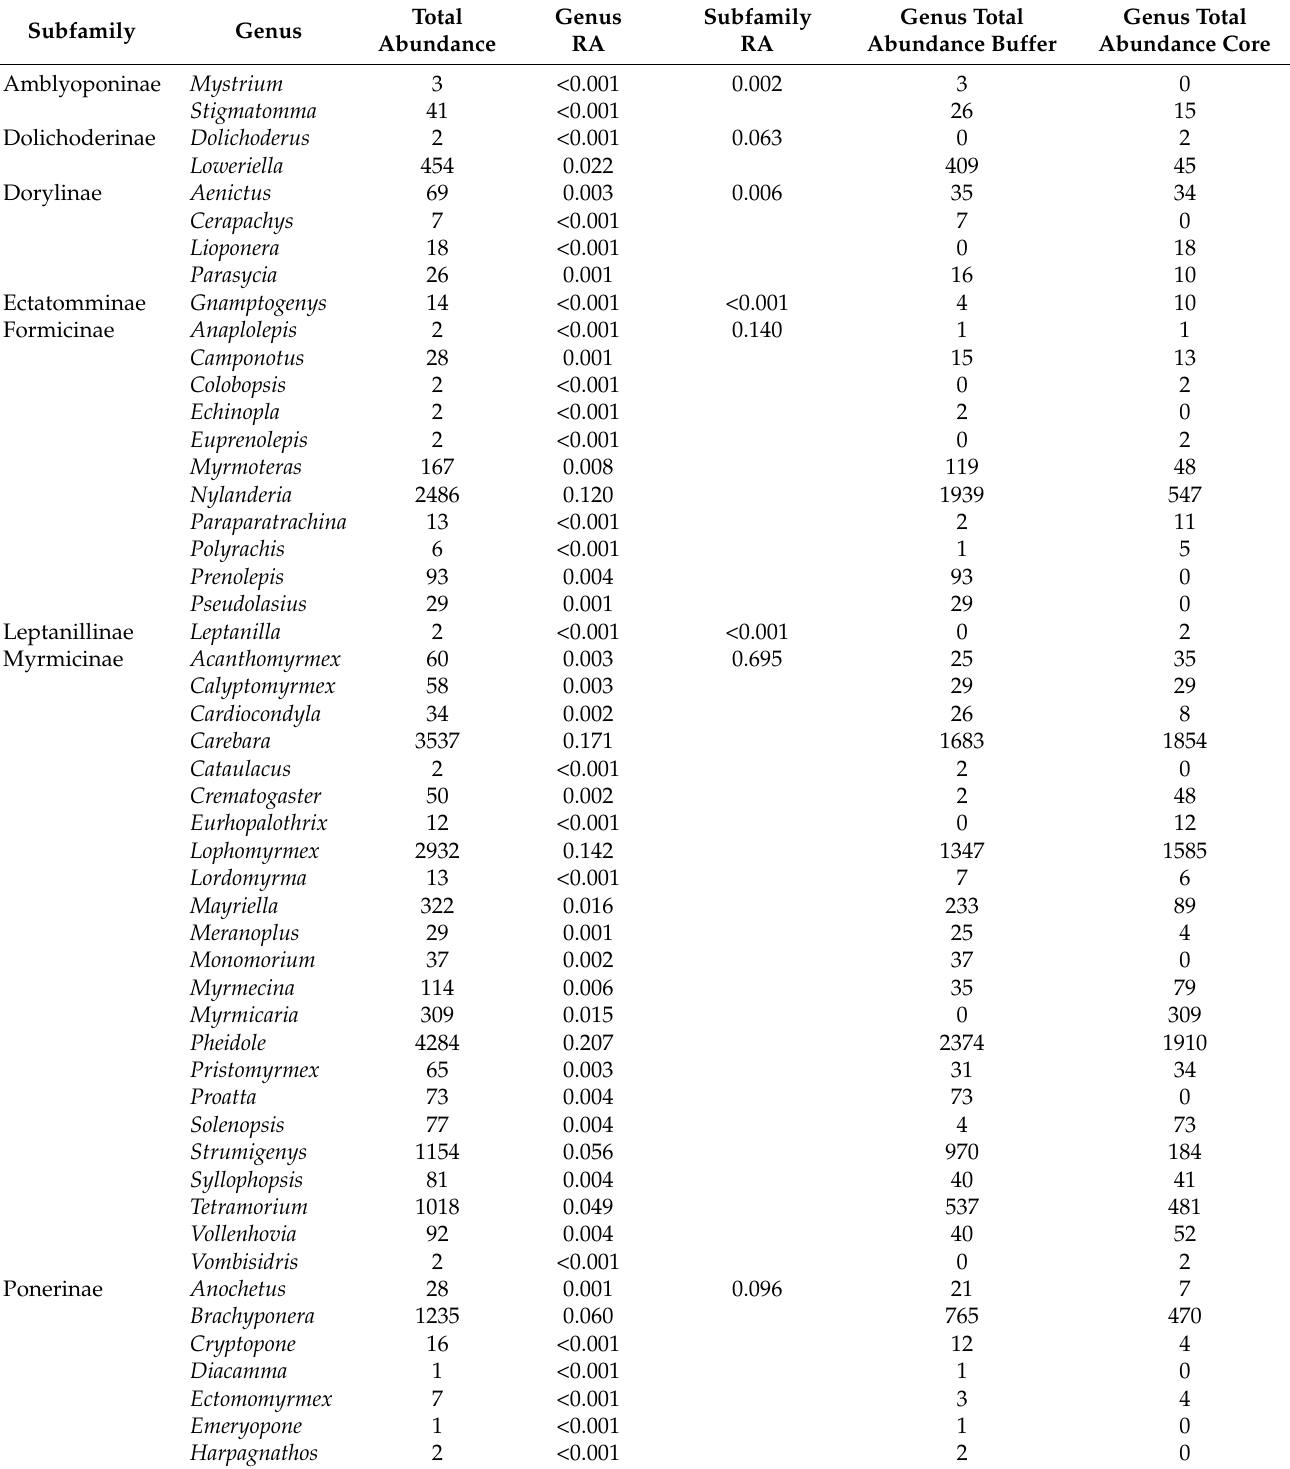
Table 1. Relative abundance of all genera collected across all plots. RA = relative abundance. Values represented as